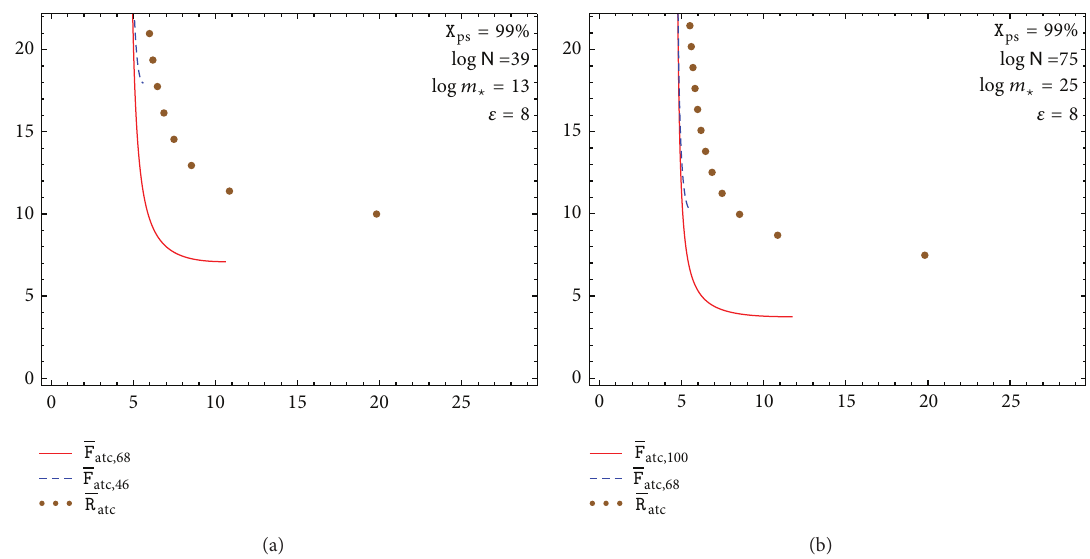
Figure 4: The adjusted tradeoff coefficients in relation to the precomputation coefficients for the perfect fuzzy rainbow, perfect rainbow, and nonperfect fuzzy rainbow tradeoffs at 99 % success rate (bottom: X